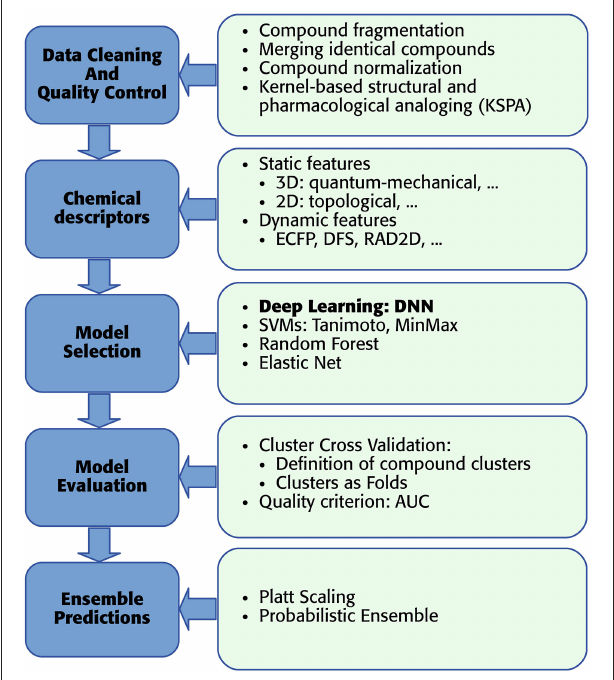
FIGURE 6 | DeepTox pipeline for toxicity